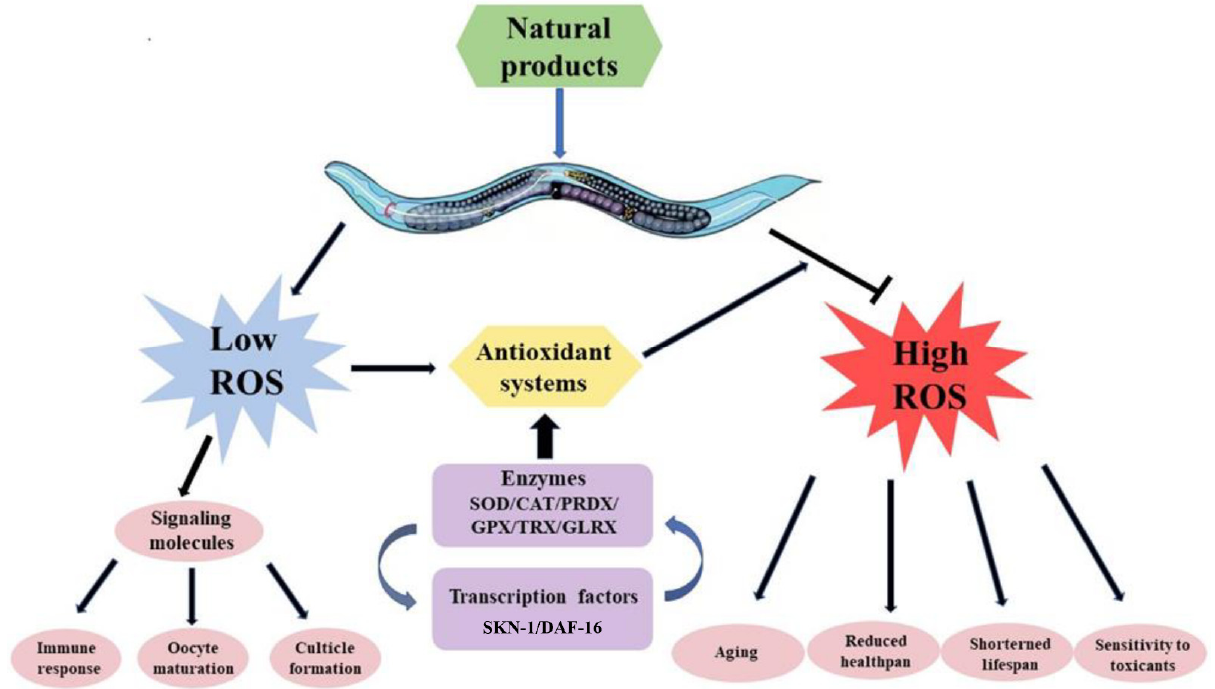
Figure 1. ROS-induced oxidative stress in C. elegans . Natural products could induce ROS in worms. At low concentrations, ROS act as signaling molecules to regulate the immune response,